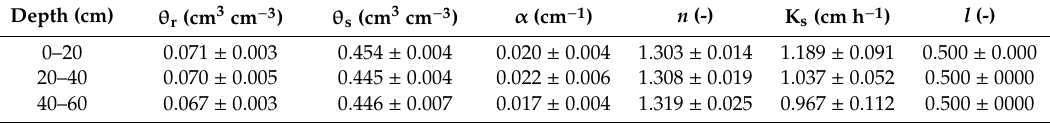
Table 2. Soil hydraulic parameters obtained from Rosetta.